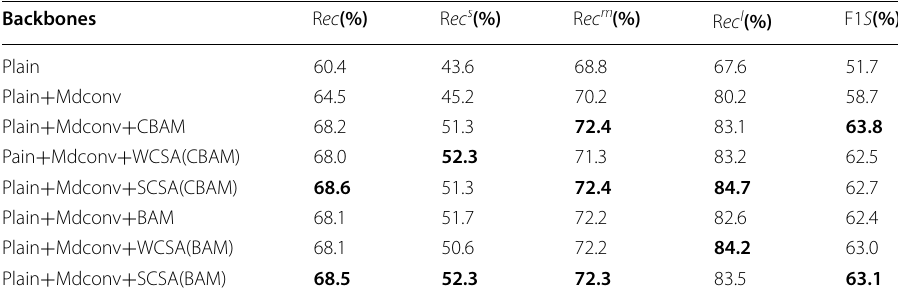
Table 2 Comparisons of recall (rec) and F1-score (F1S) on DarkNet-53 and YOLOv3